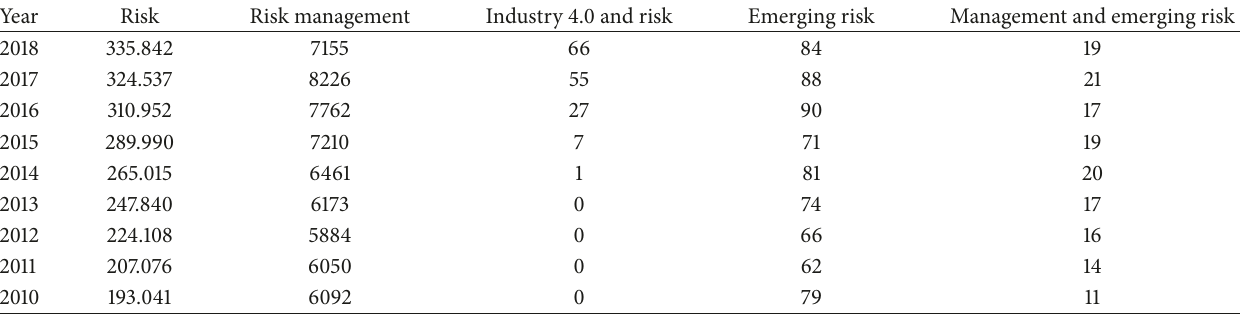
Table 2: Number of scientific publications on risk and emerging risk in the Industry 4.0 (Results from the Web of Science. Timespan: 2010- 2018; All databases; Field tag: Topic).